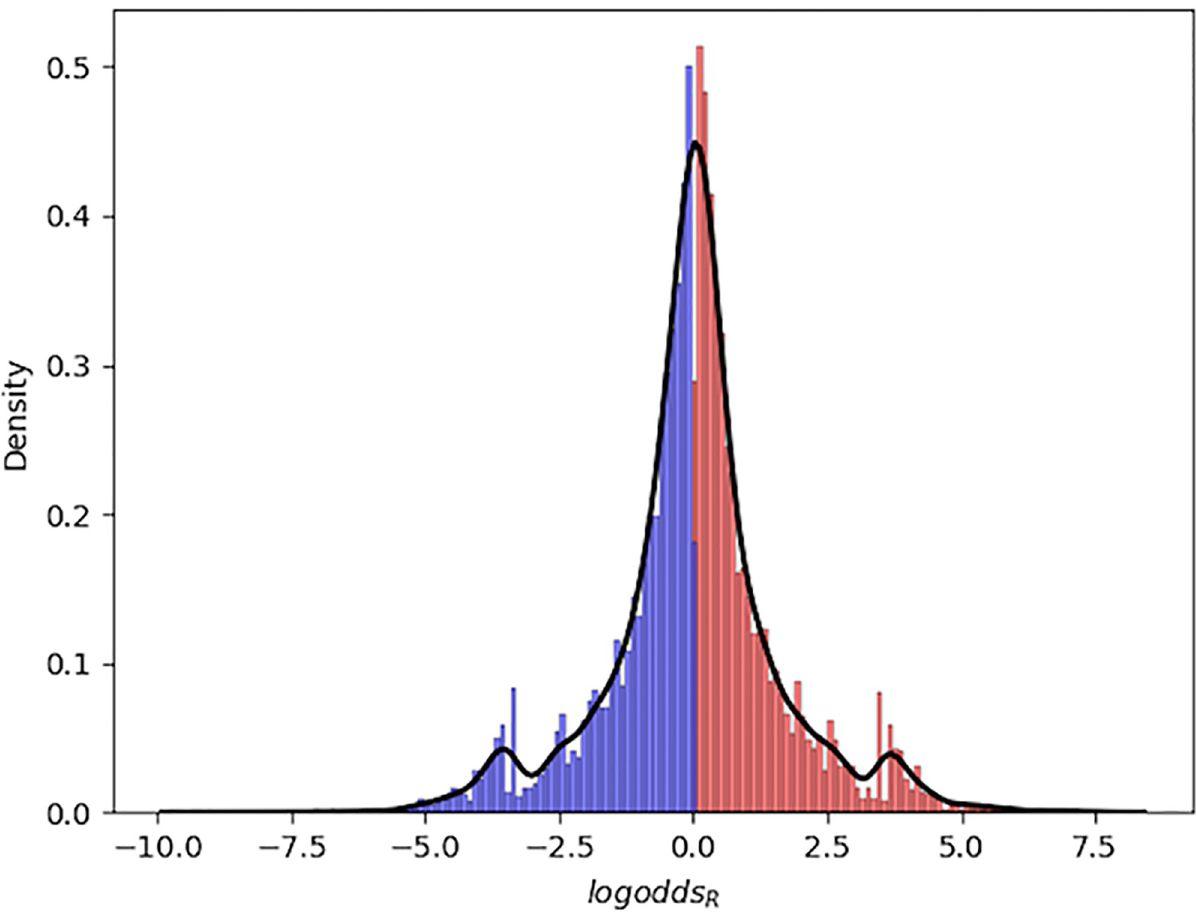
Fig 1. Distribution of logodds by a Democrat, corresponding to each word in our corpus (see text for details; logodds Democratic words ( logodds R < 0) are blue. The black line shows the approximate density of the distribution.